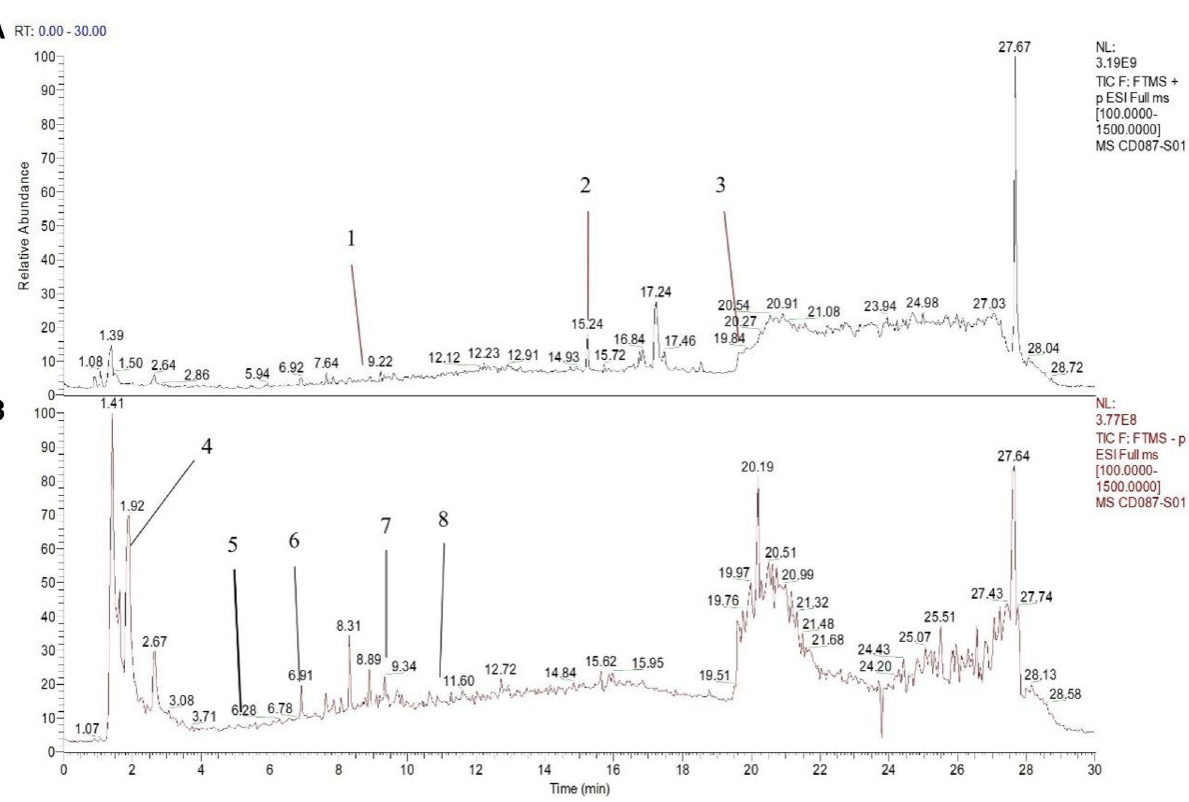
Figure 4. Total ion flow pattern of the antioxidants in Bushen-Tiaojing-Fang. ( A ) Positive ion mode; ( B ) negative ion